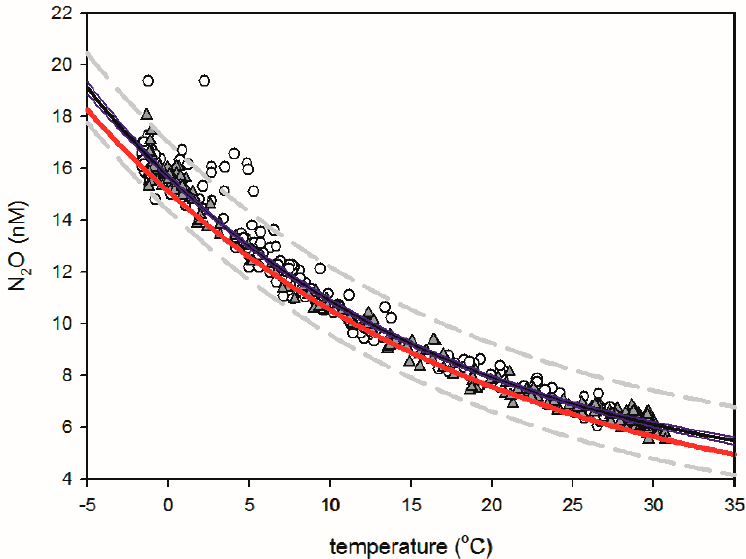
Figure 3. Exponential decay of N 2 O concentration against surface seawater temperature. y = (2.3703 ± 0.1777) + (13.017 ± 0.1711)exp[( − 0.459 ± 0.0011) · x ] ( y = (2.4704 ± 0.0947) + (12.7443 ± 0.0888)exp[( − 0.459 ± 0.0007) · x ]) ( p < 0.0001). The open circles and gray triangles are data obtained during the 4th and 27th Chinese National Antarctic Research Expedtion. The regression line is shown as the black line, and the 95% prediction band is shown as the gray dashed line. The red line is the regression line of the equilibrium concentration against surface seawater temperature.